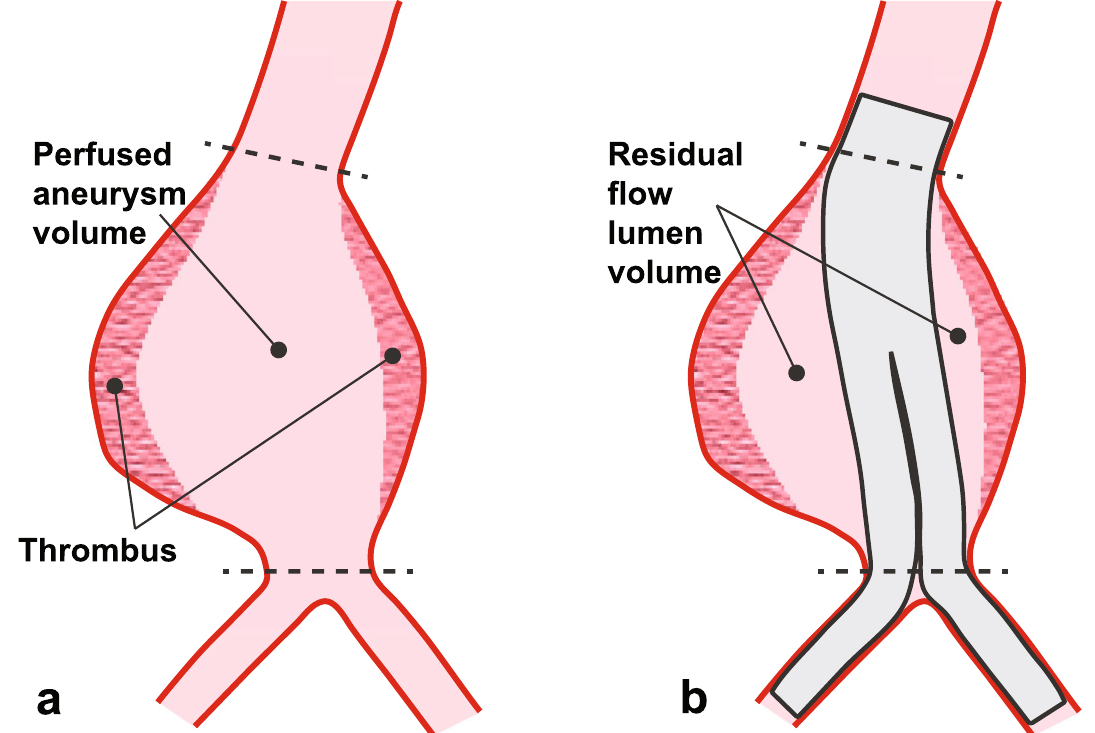
Fig. 1 Schematic of the volumes associated with preparation for sac embolization. a Three‑dimensional aneurysm volume was measured between positions of non‑aneurysmal aorta diameter proximal and distal to the aneurysm (dotted lines, with applicable adjustments for individual anatomy). Perfused aneurysm volume was the aneurysm volume exclusive of preexisting thrombus. b The residual flow lumen volume was calculated by subtraction of the endograft volume (estimated from endograft dimensions in each product’s instructions for use) from the perfused aneurysm